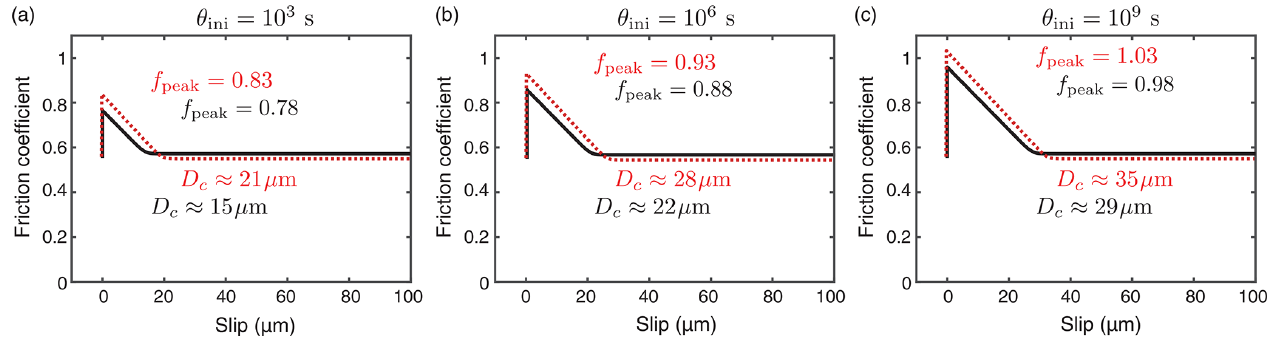
Figure 3. Illustration of the rate- and state-dependence of the peak and dynamic friction coefficients, f peak and f dyn , respectively, as well as the effective slip-weakening distance D c . (a–c) Evolution of the friction coefficient with slip for points with the same initial friction coefficient of 0.58 but different values of the initial state variable θ ini , corresponding to different histories of previous motion. The initially locked point slips at an imposed slip rate of V = 1cm/s (black) or V = 1m/s (red), to approximately reproduce transition from the locked state to dynamic sliding as the rupture propagates through. For a given slip rate, the friction evolves to a new steady-state level, f dyn = 0 . 54 and f dyn = 0 . 56 for V = 1m/s and V = 1cm/s, respectively. These levels are similar, as expected from the logarithmic dependence on the slip rate and a narrow range of dynamic slip rates. The peak friction coefficient and effective slip-weakening distance vary more significantly with θ ini , where the peak friction coefficient increases for higher θ ini associated with longer inter-event healing times. The example uses typical laboratory values of (a − b) = 0 . 004, f ∗ = 0 . 6, D RS = 1µm, and V ∗ = 10 − 6 m/s. Table 1. Model parameters used in simulations of earthquakes and aseismic